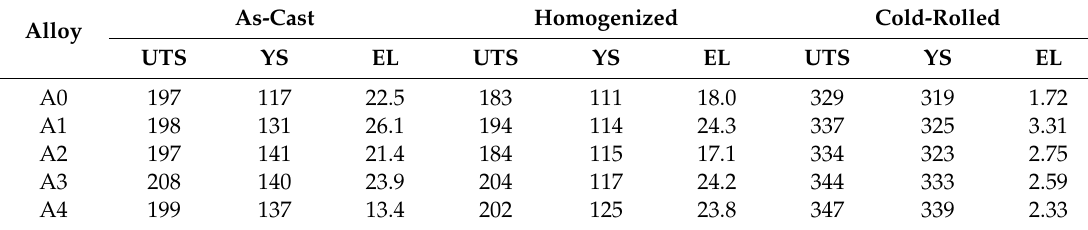
Table 3. Mechanical properties of 5052 aluminum alloys (ultimate tensile strength (UTS), yield strength (YS) MPa and elongation (EL)